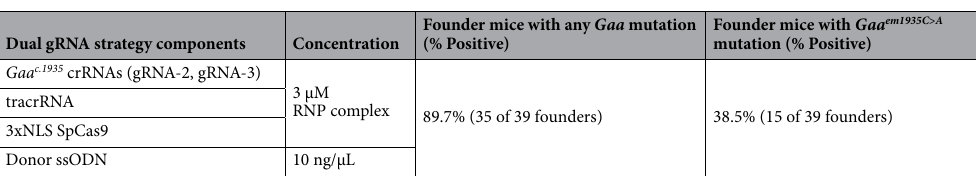
Table 2. Dual overlapping gRNA strategy and outcomes of Gaa em1935C > A mouse generation. Dual overlapping gRNA components and concentrations used in pronuclear microinjection of C57BL/6NJ fertilized zygotes are outlined. Each crRNA was hybridized with tracrRNA at a 1:1 ratio to form gRNA duplexes. Equimolar amounts of gRNAs were then combined with 3xNLS SpCas9 at a 1:1 ratio to form the RNP complex. Numbers of founder mice positive for any Gaa mutation and founder mice with the Gaa c.1935 KI mutation are reported as